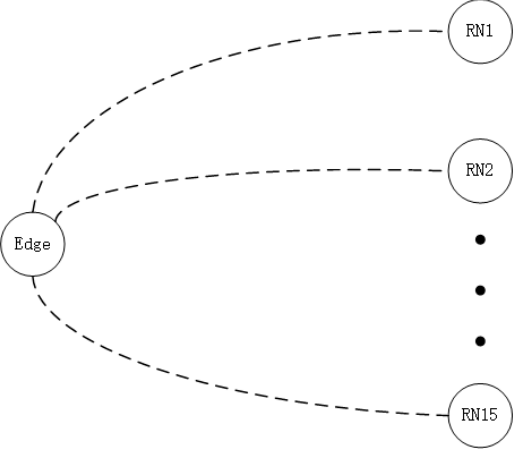
Figure 4. Experimental Scenario 1 topology (Black dots represent replica nodes RN3 to RN14).